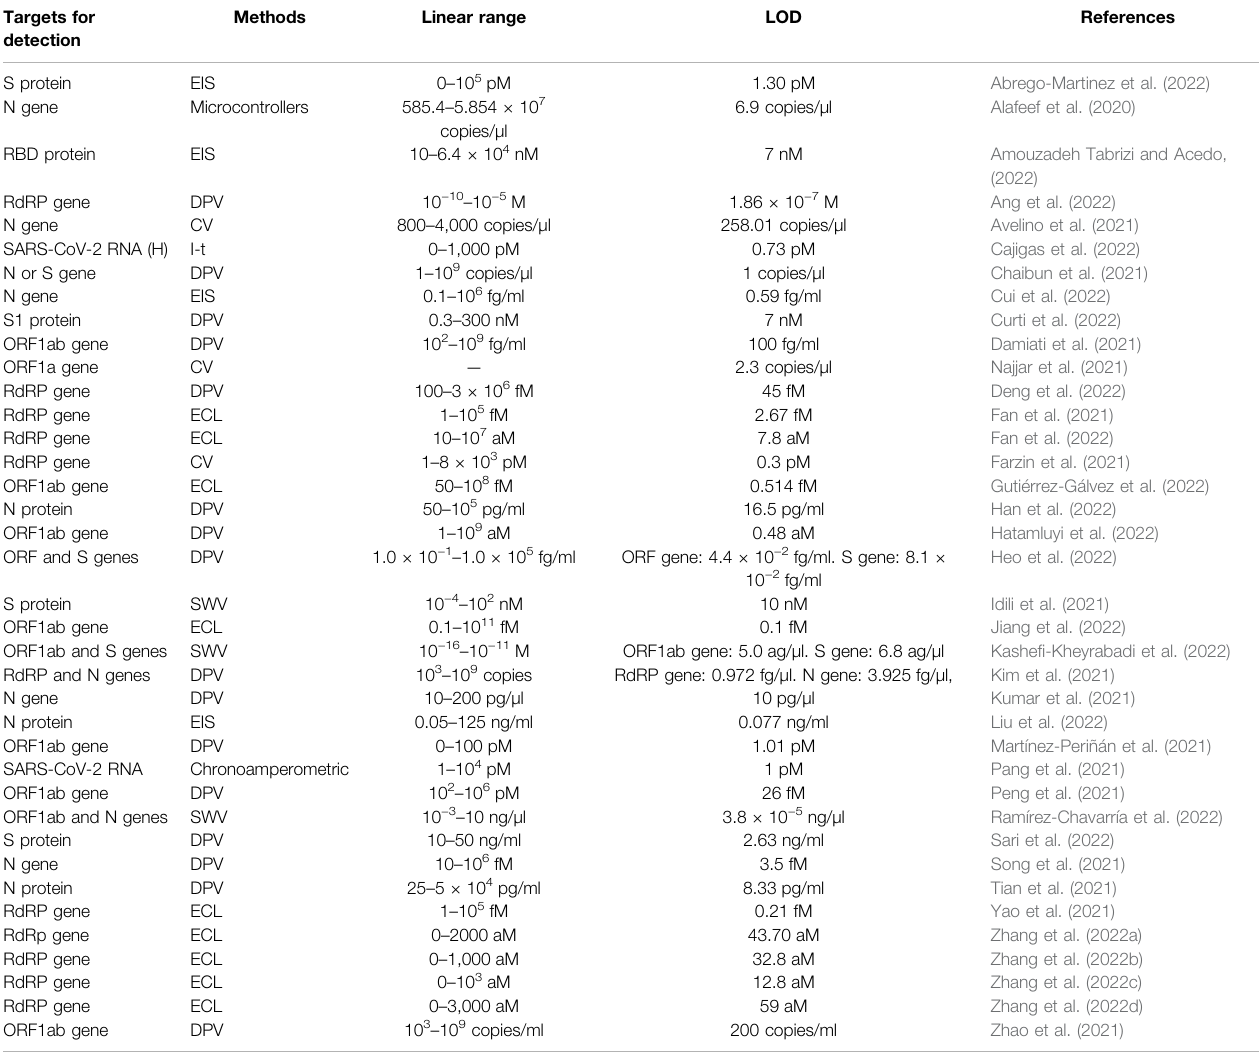
TABLE 1 | Comparison of SARS-CoV-2 electrochemical genetic sensor detection methods. Targets for